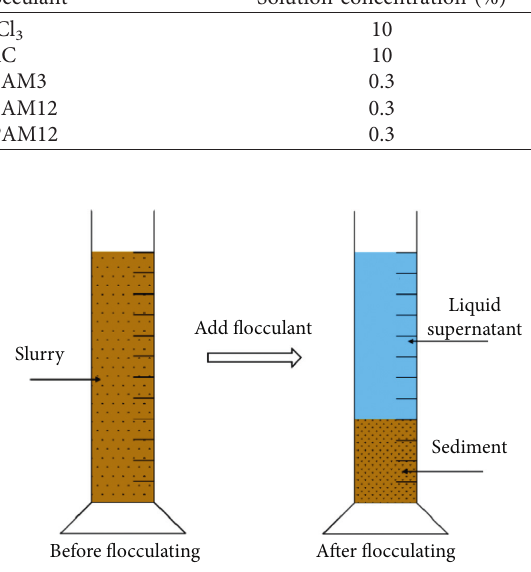
Figure 2: Schematic diagram of the flocculation settlement